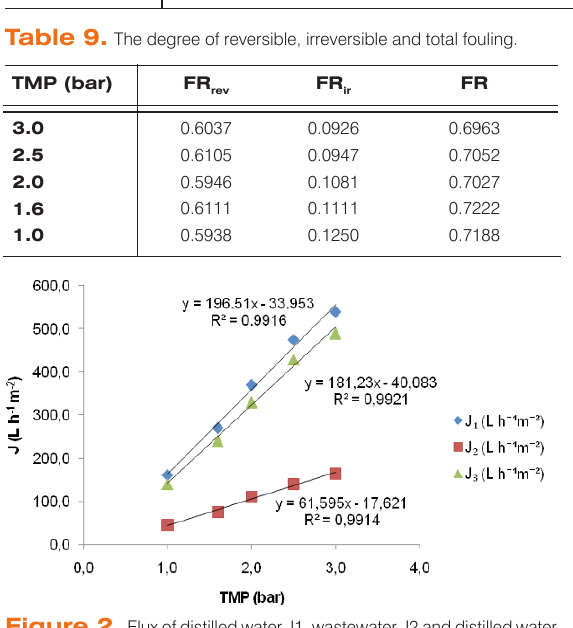
Figure 2. Flux of distilled water J1, wastewater J2 and distilled water after backwash J3, as a function of